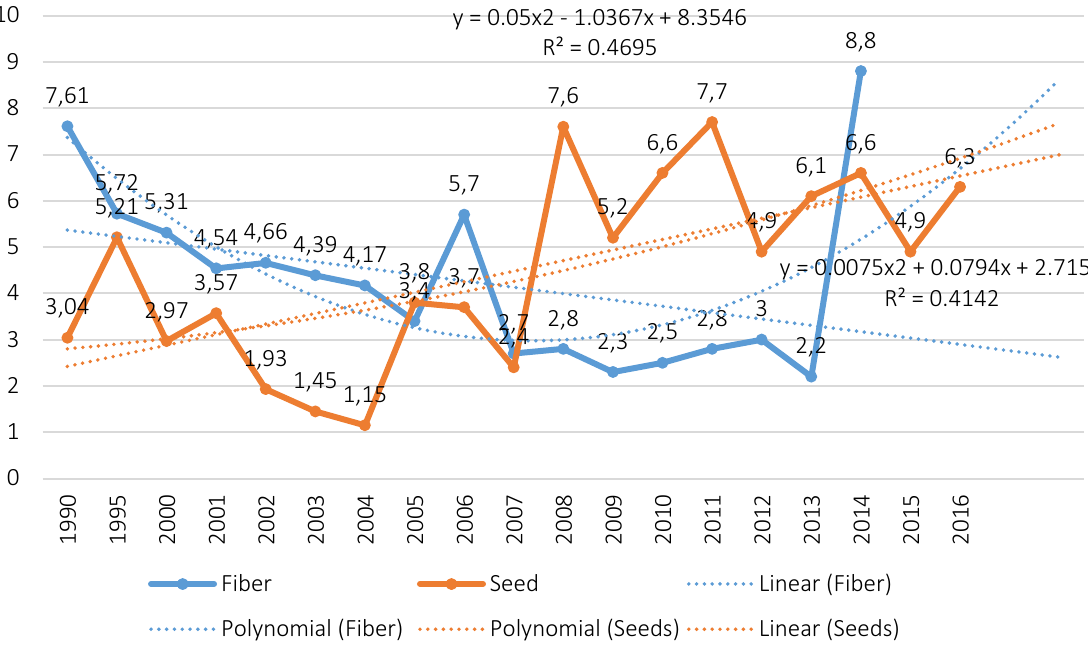
Figure 3. Yield of fiber and seeds of technical hemp in Ukraine,